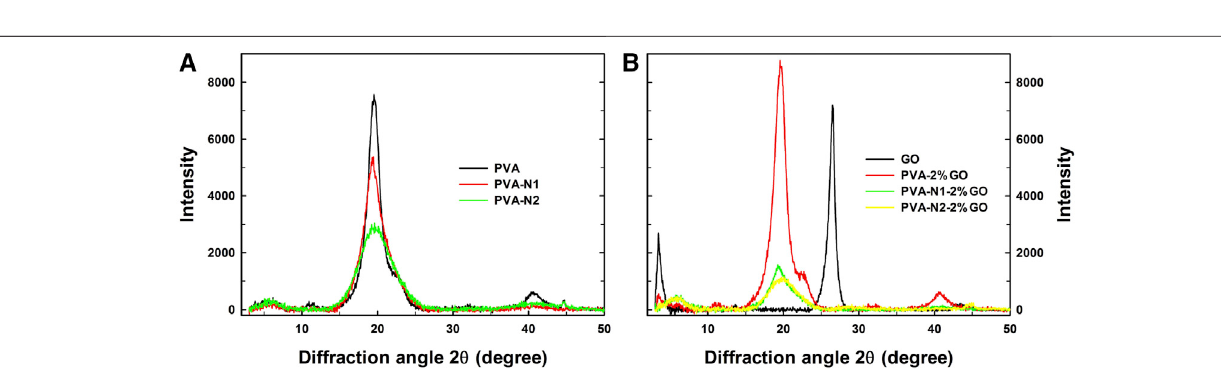
Frontiers in Chemistry |